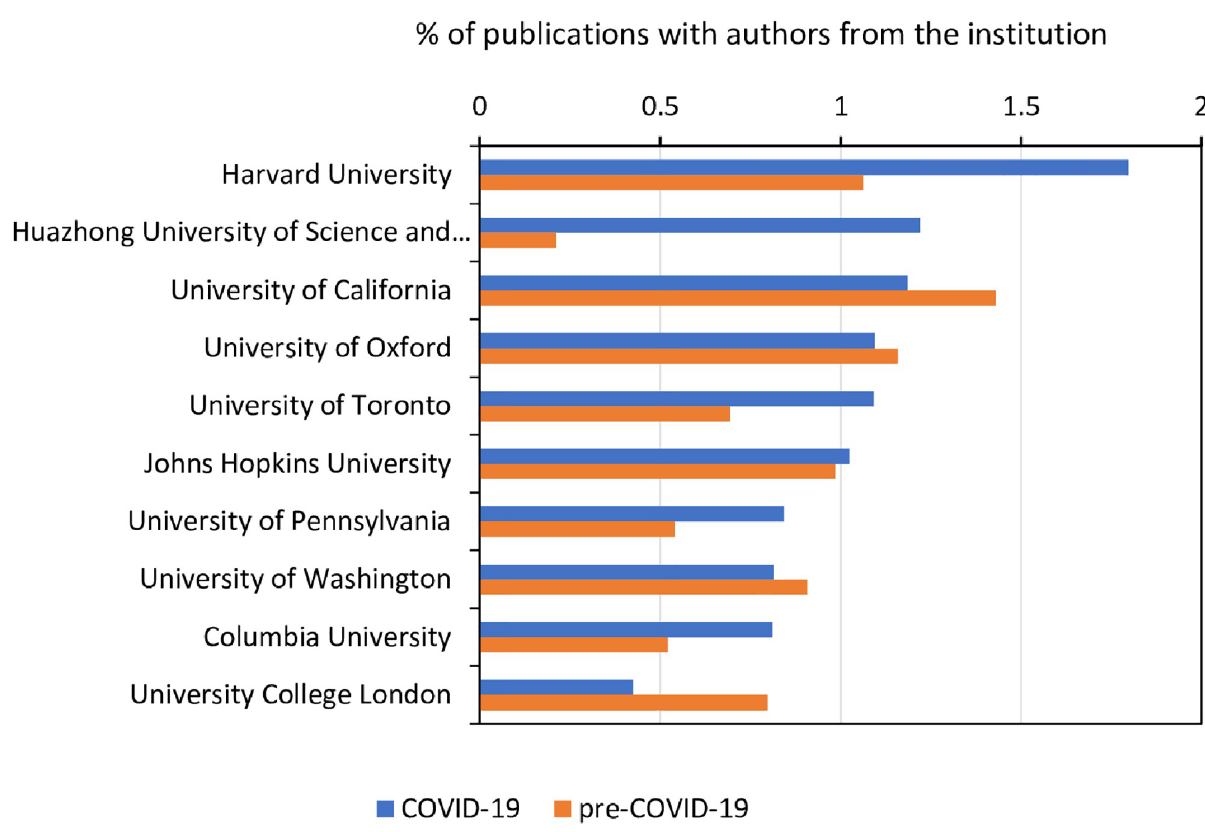
Fig 4. Top institutions in COVID-19, 2020. The percentage shares of publications in global articles of top 10 prolific institutions in COVID-19 (2020) and pre-COVID-19 (2018–2019) are shown.